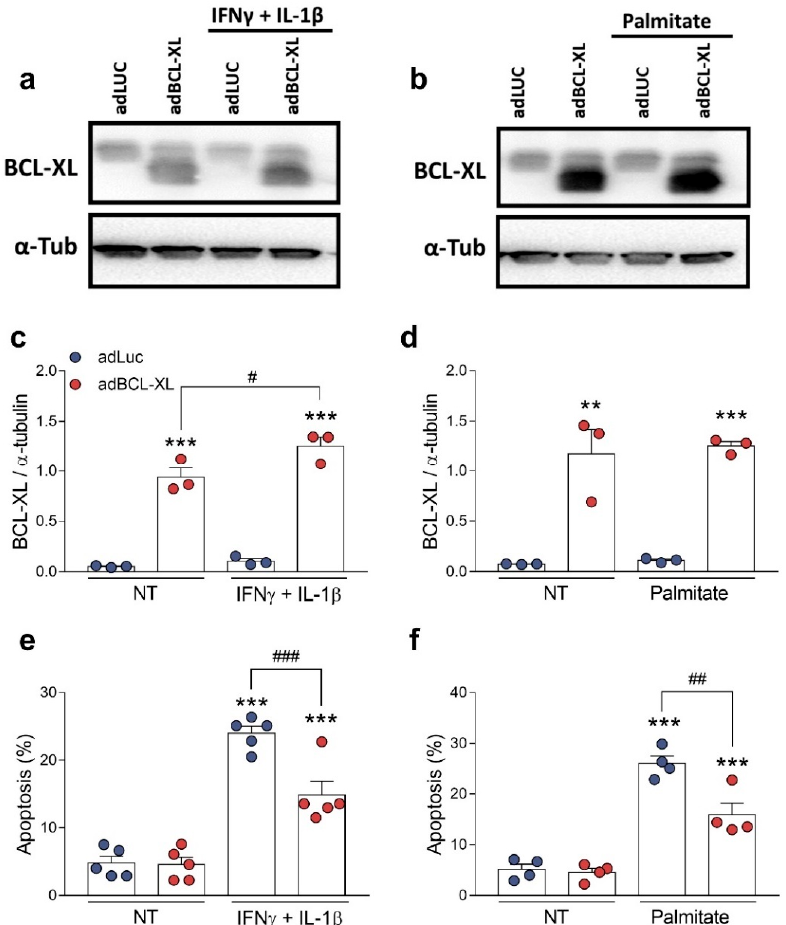
Figure 4. BCL-XL overexpression protects rat β -cells against cytokine- and palmitate-induced apop- tosis. INS-1E cells were infected with adenoviral (ad) vectors encoding luciferase (adLUC, blue dots) or rat BCL-XL (adBCL-XL, red dots). After 48 h of recovery, cells were left untreated (NT) or treated with either IFN γ + IL-1 β (10 and 100 U/mL, respectively) ( a , c , e ) or 0.5 mM palmitate ( b , d , f ) for 24 h. ( a – d ) Protein expression was measured by Western blot. Representative images of three independent experiments are shown in ( a , b ) and densitometry results are presented for BCL-XL ( c , d ). ( e , f ) Apoptosis was assessed using HO/PI staining. Results are the means ± SEM of the 3–5 independent experiments, where each dot represents an independent experiment. ** p ≤ 0.01 and *** p ≤ 0.001 vs. untreated (NT) and infected with the same adenoviral vector; # p ≤ 0.05, ## p ≤ 0.01, and ### p ≤ 0.001, as indicated by bars. Two-way